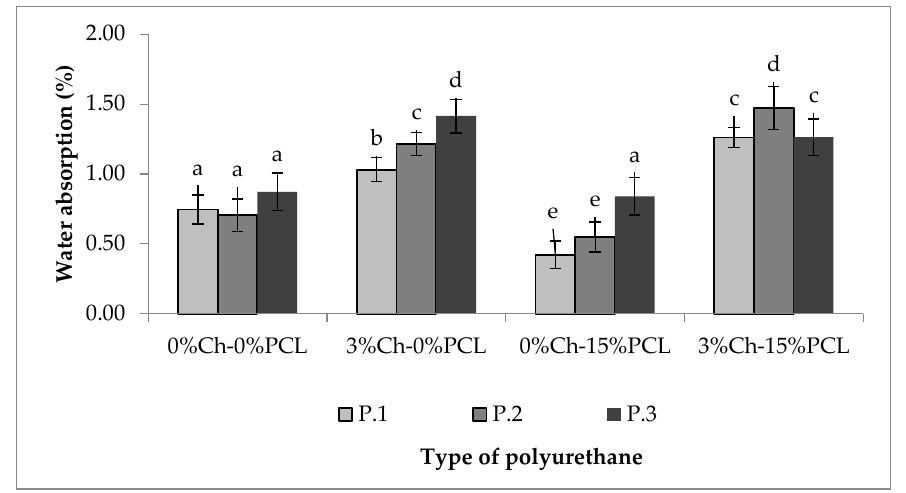
Figure 5. Water absorption rate over 72 h. Absorption results are expressed as the mean ± SD (n = 3). Bars with different letters (a–d) indicate significant differences ( p < 0.05).